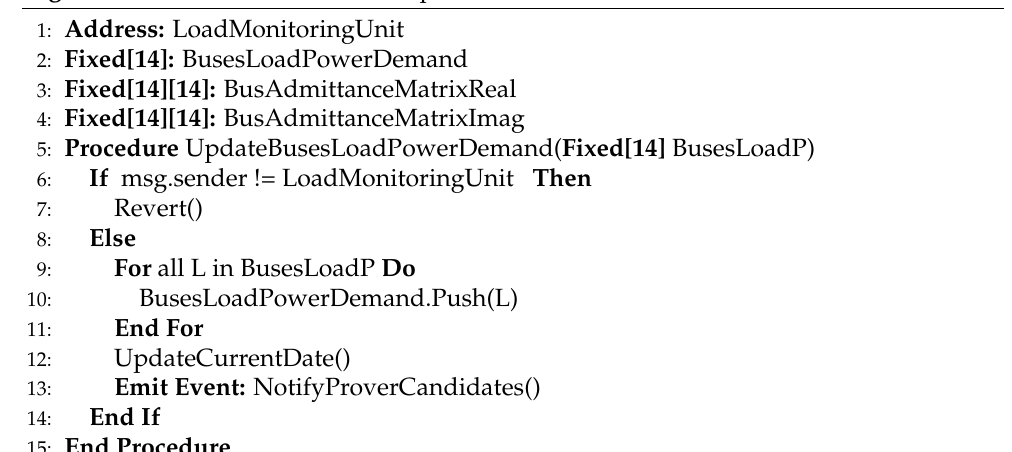
Algorithm 7 OPF Smart Contract: UpdateBusesLoadPowerDemand